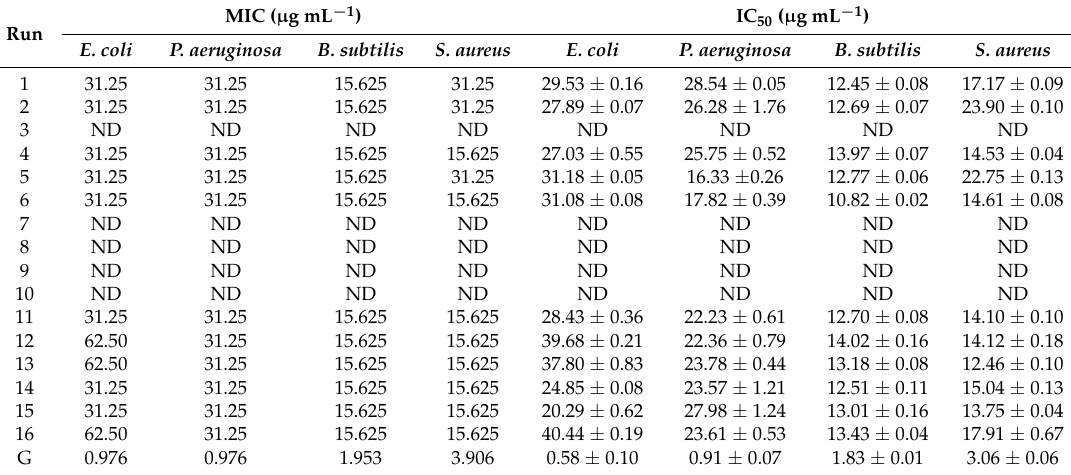
Table 6. Comparison of minimum inhibitory concentrations (MIC) and 50% Growth Reduction (IC 50 ) of supercritical fluid sage leaf extracts against Escherichia coli , Pseudomonas aeruginosa, Bacillus subtilis , and Staphylococcus aureus ( µ g mL − 1